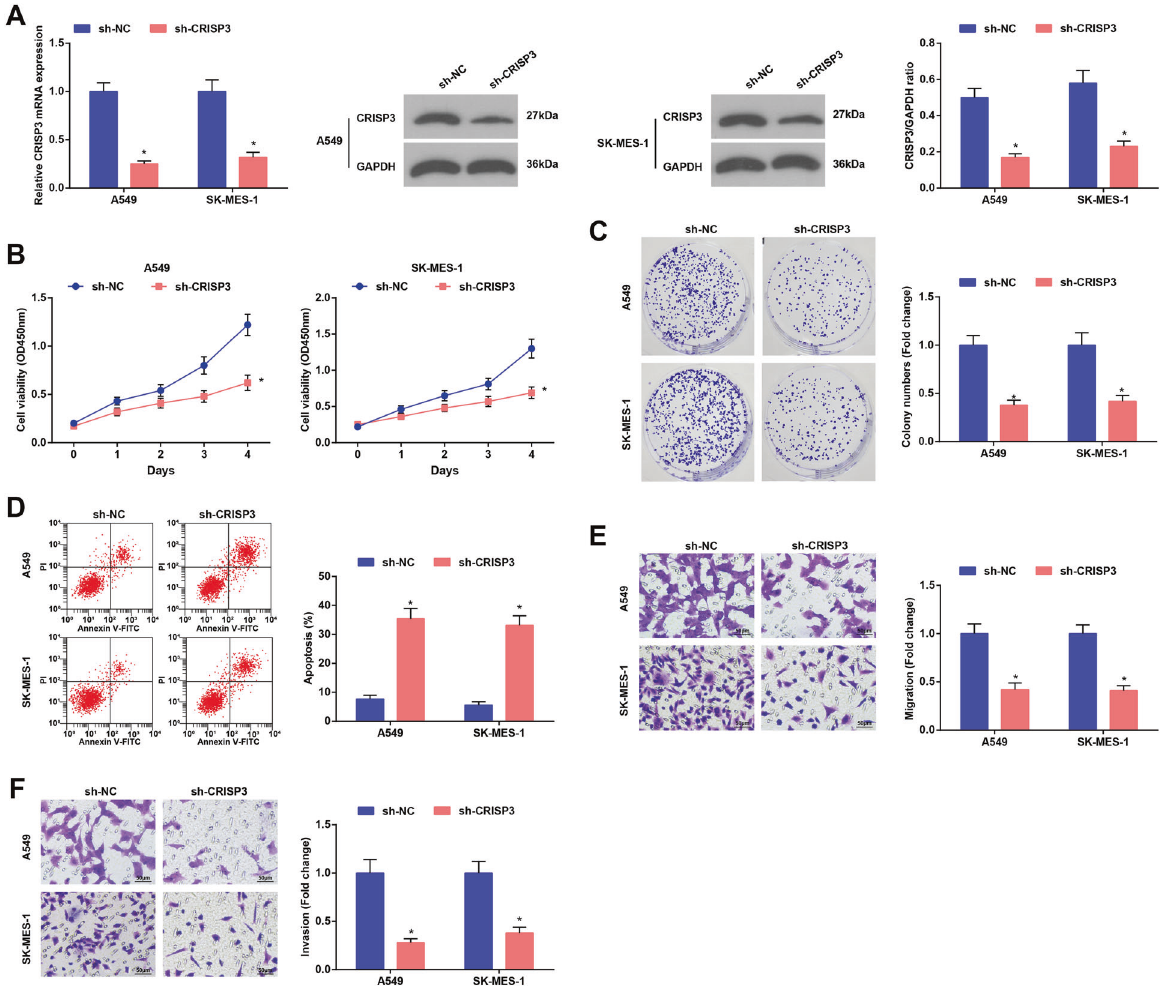
Fig. 6 CRISP3 reduction suppresses the malignancy of LC cells. A CRISP3 mRNA and protein expression in LC cells was detected using RT- qPCR and Western blot analysis. B Cell viability was assessed using CCK-8 assay. C Colony formation ability of cells was detected using cell colony formation assay. D apoptosis of cells was assessed using fl ow cytometry. E and F Migration and invasion of cells was detected using Transwell assay; * P < 0.05 vs. the sh-NC